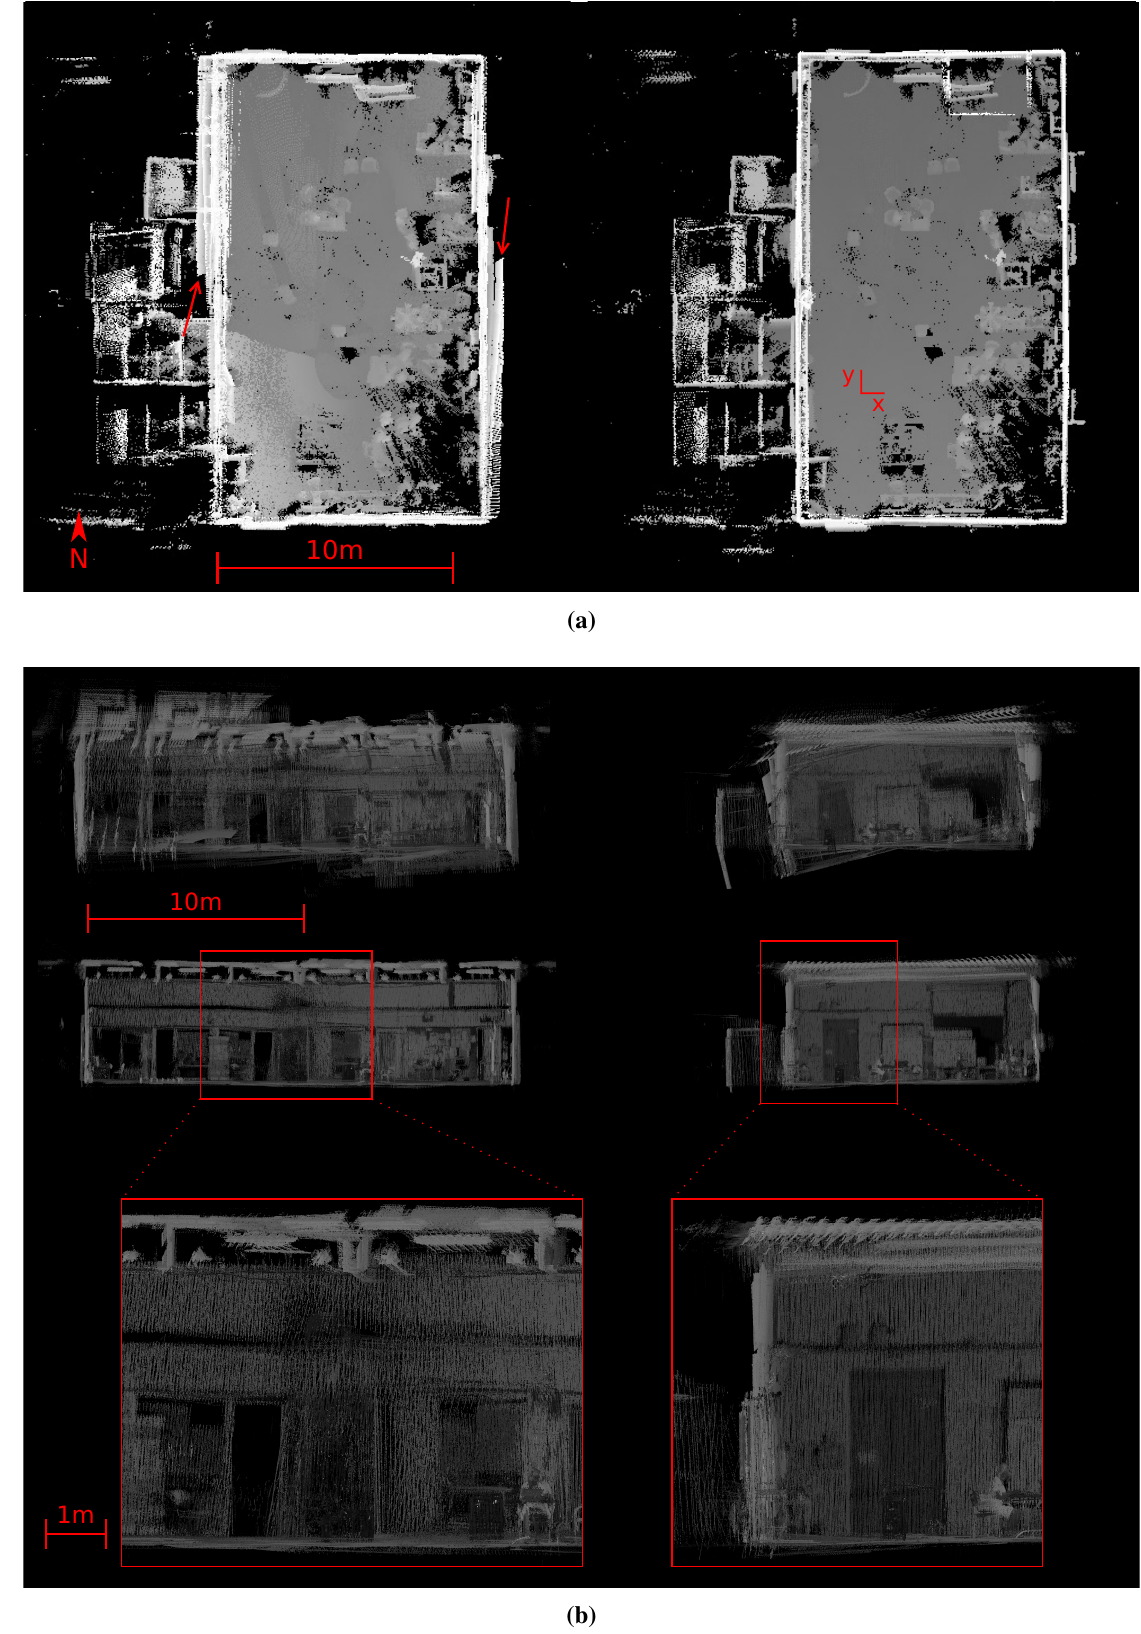
Figure 6. 3D point cloud of Experiment 1. ( a ) Bird’s eye view before (left) and after optimization (right). The gaps between the walls (red arrows) are closed by optimization. Depicted is the origin of the iSpace coordinate system; ( b ) Side view with reflectance values before (top) and after optimization (bottom). The quality improved, but the marked areas remain slightly